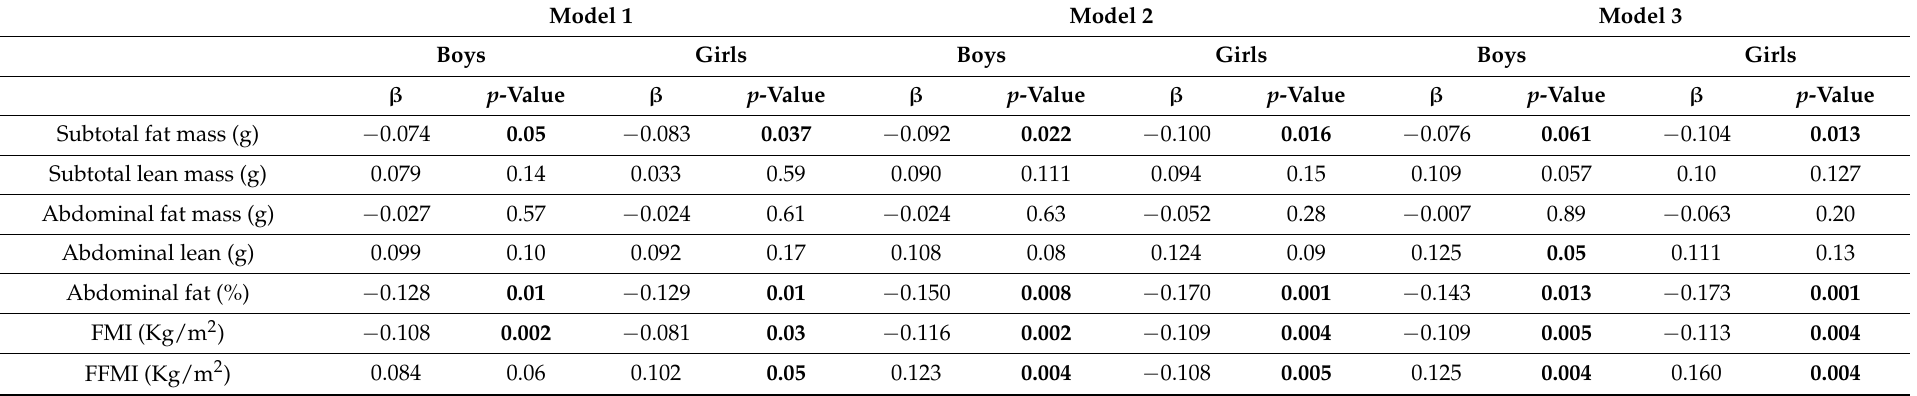
Table 3. Associations between MVPA and body composition parameters. Each model was adjusted by a number of perinatal and lifestyle behavior variables, as pointed out